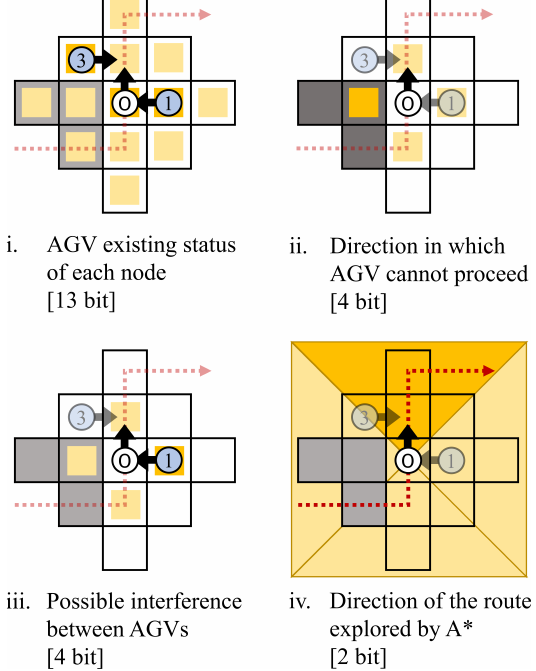
Figure 6. Events to be observed and amount of information. Each event and the amount of informa- tion required at that time is